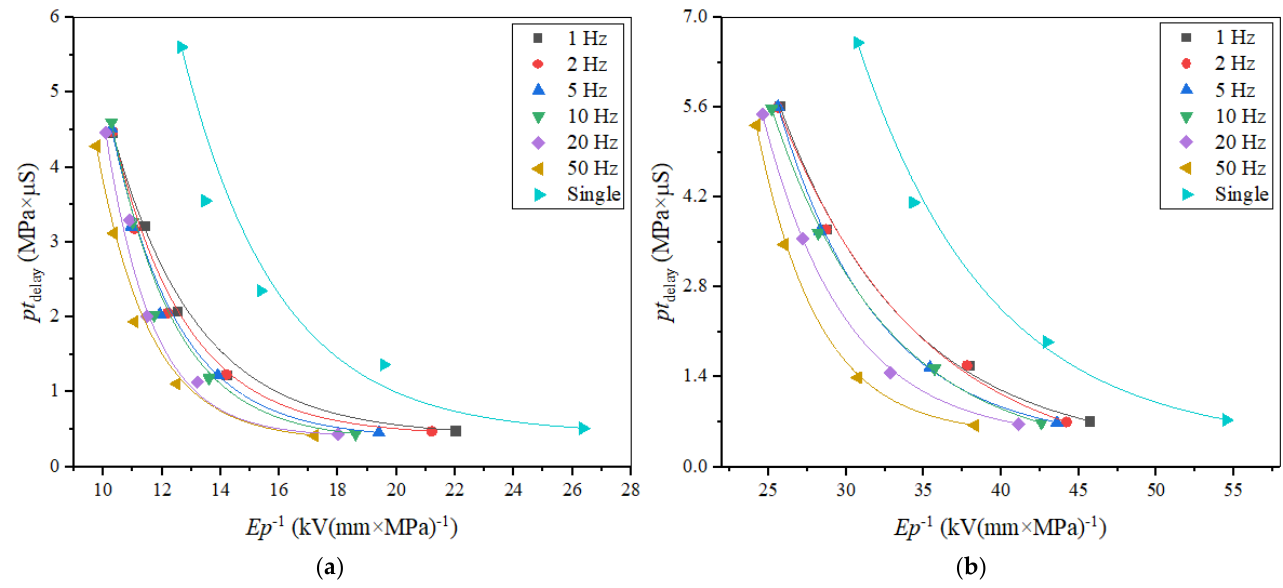
Figure 19. Dependence of E / p on pt delay in ( a ) air and ( b ) SF 6 .